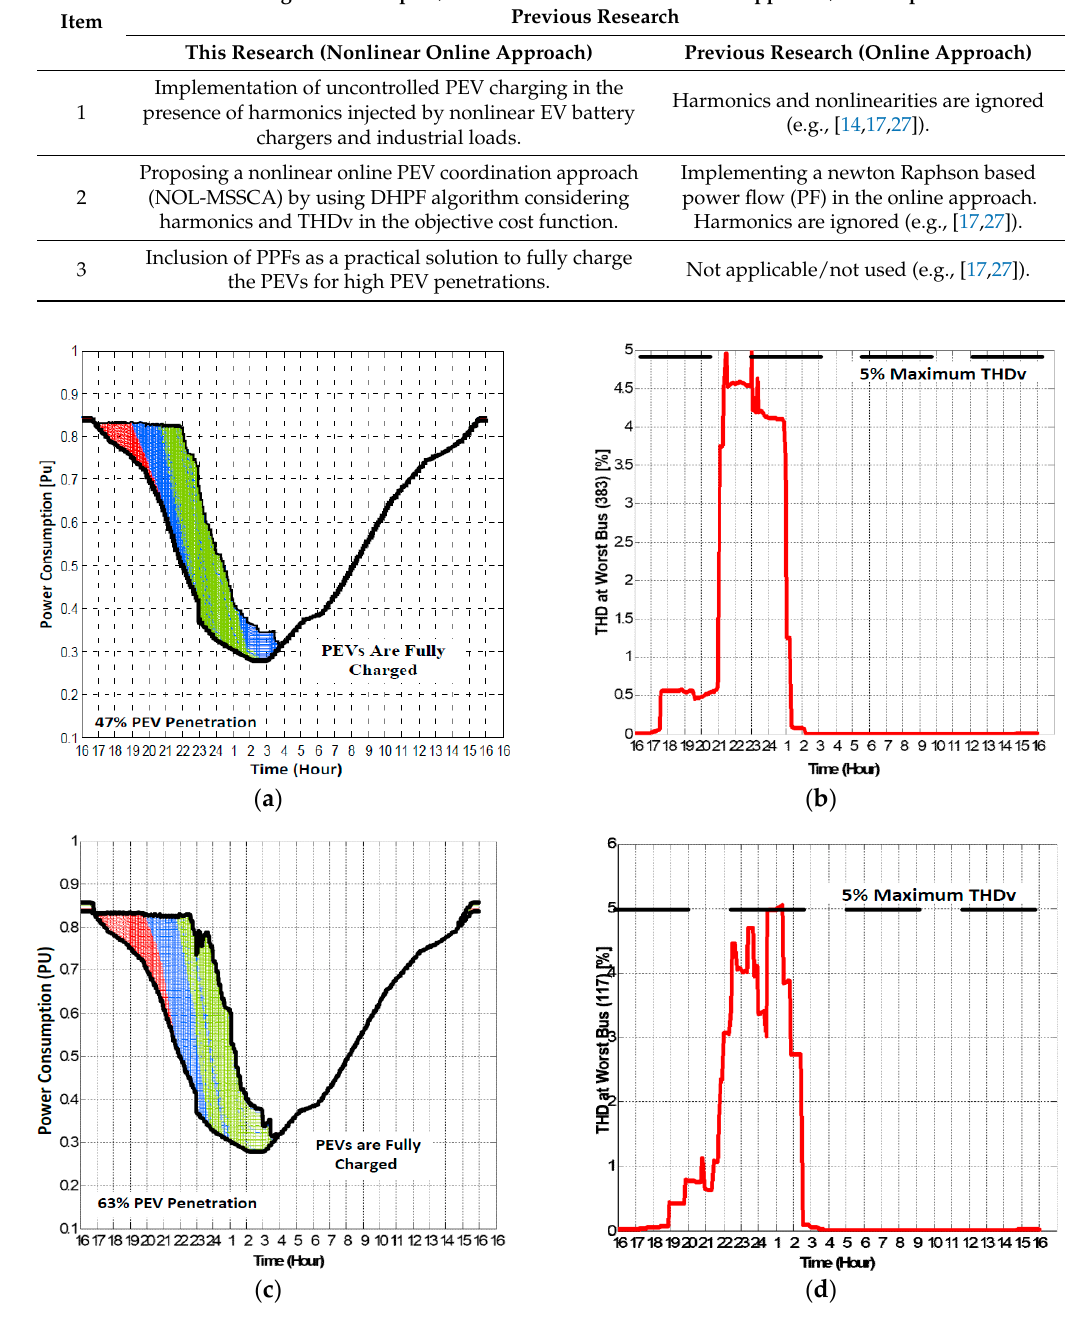
Figure 7. Simulation results for Case 3: Installation of PPF with NOL-MSSCA considering harmonics including power consumption and THDv; ( a , b ) 47% PEV penetration; ( c , d ) 63% PEV penetration.